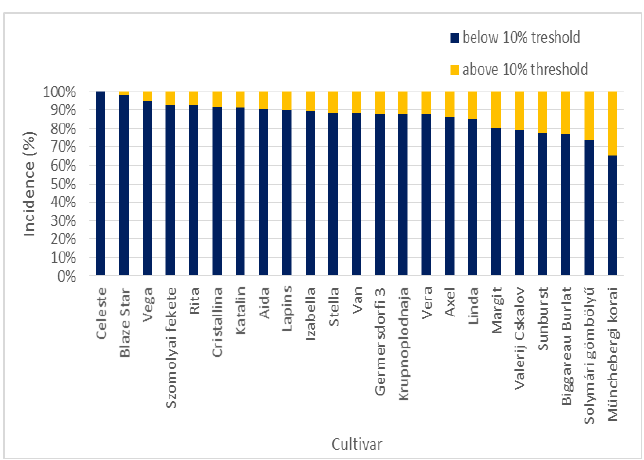
Figure 1. Overall classification of 23 sweet cherry cultivars according to the 10% disease threshold level for chery leaf spot (distributions of above and under 10% disease incidence).